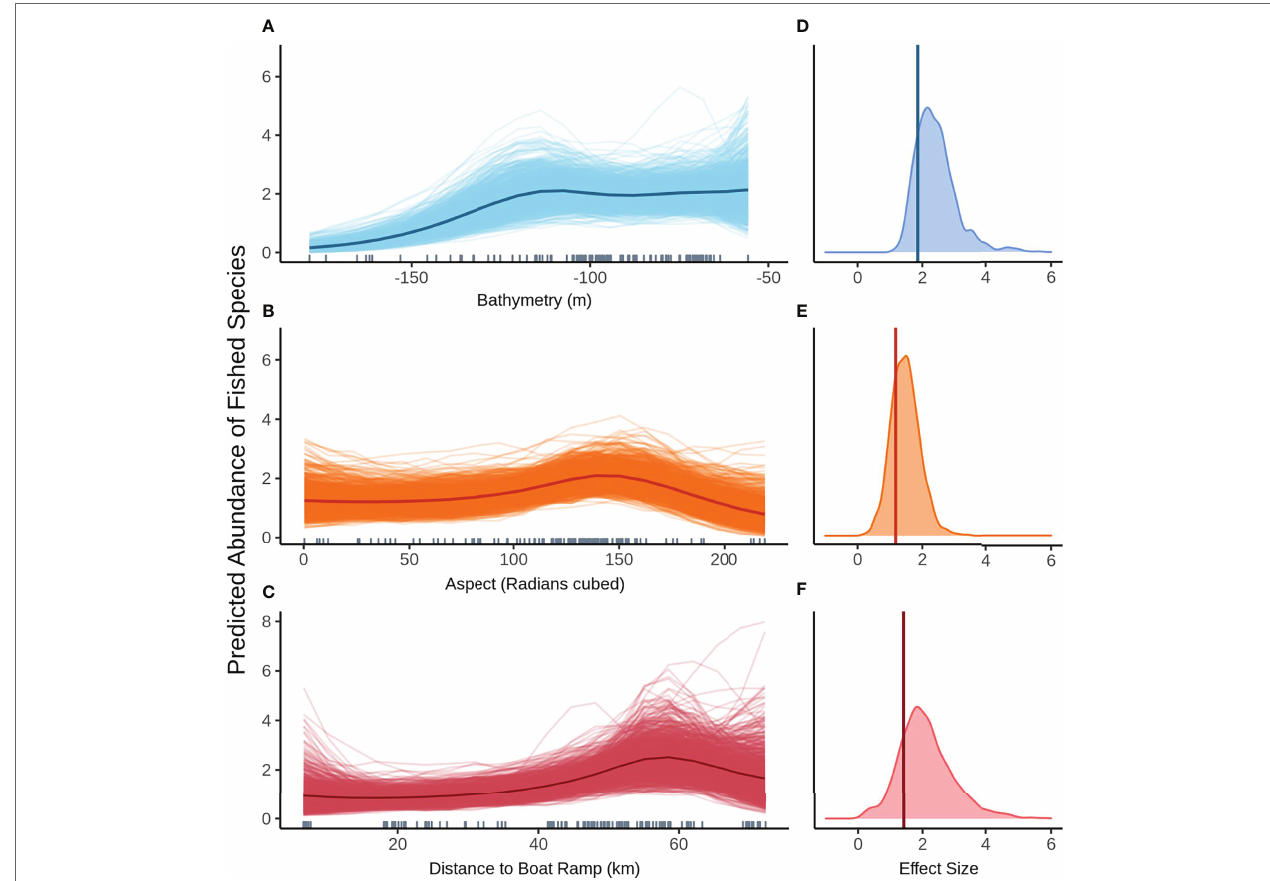
FIGURE 4 | Predicted values for the top ranked model for abundance of fished species when field of view variables were not included - (A) bathymetry (m), (B) aspect (radians cubed), (C) distance to boat ramp (km). Density plots of effect size are also plotted for each aforementioned predictor – (D–F) respectively – with a vertical line indicating the frequentist effect size